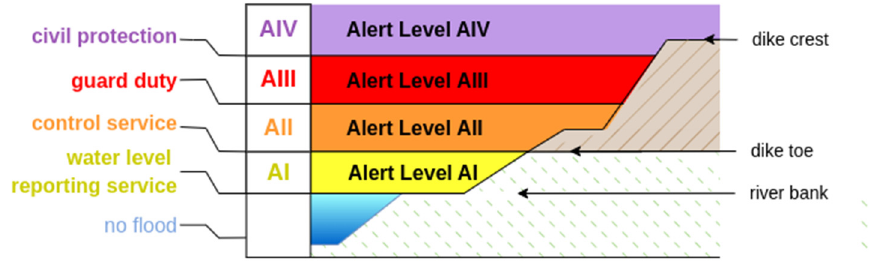
Figure 12. Alert levels for flood warnings (source: Landesamt für Umwelt Brandenburg).